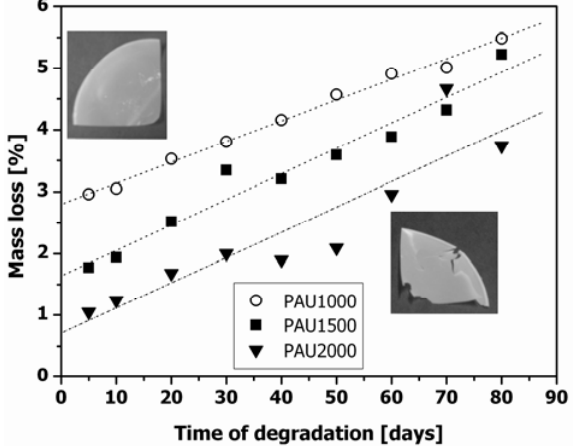
Figure 1. Mass loss of polyacylurethane (PAU) films with different soft segment lengths